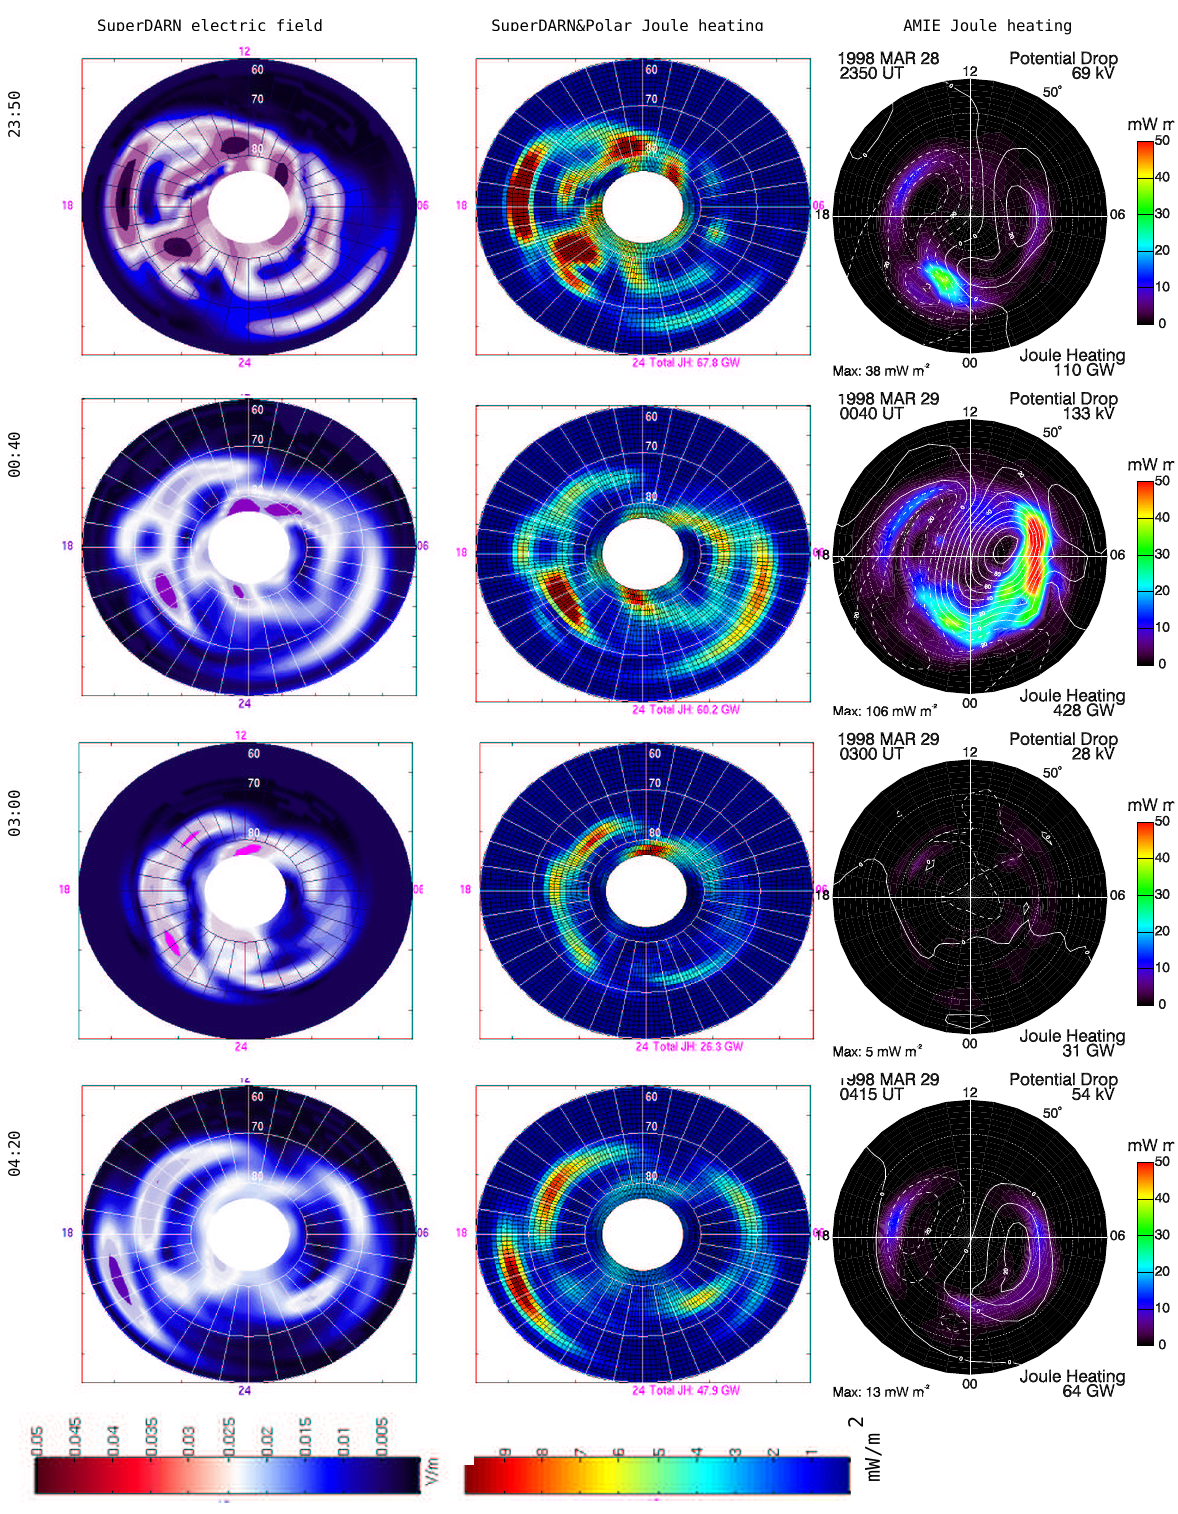
Fig. 6. SuperDARN electric field (first column), and Joule heating as computed from the SuperDARN and Polar measurements (second column), and the AMIE procedure (third column) during the onset and maximum of the first substorm (first two rows), minimum in between the substorms (third row), and near the maximum of the second substorm (last